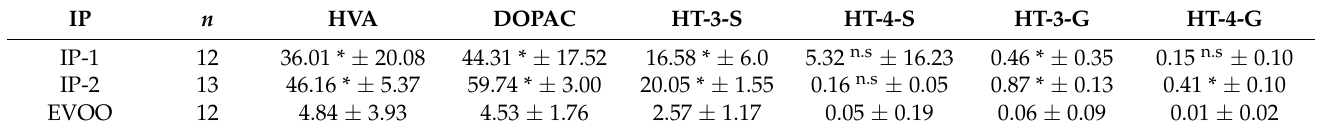
Table 5. Mean cumulative (0–12 h) excretion of HT metabolites (micromoles) ± SEM in urine. Significance vs. EVOO was as follows: *: significant at p < 0.001 level, n.s: not significantly